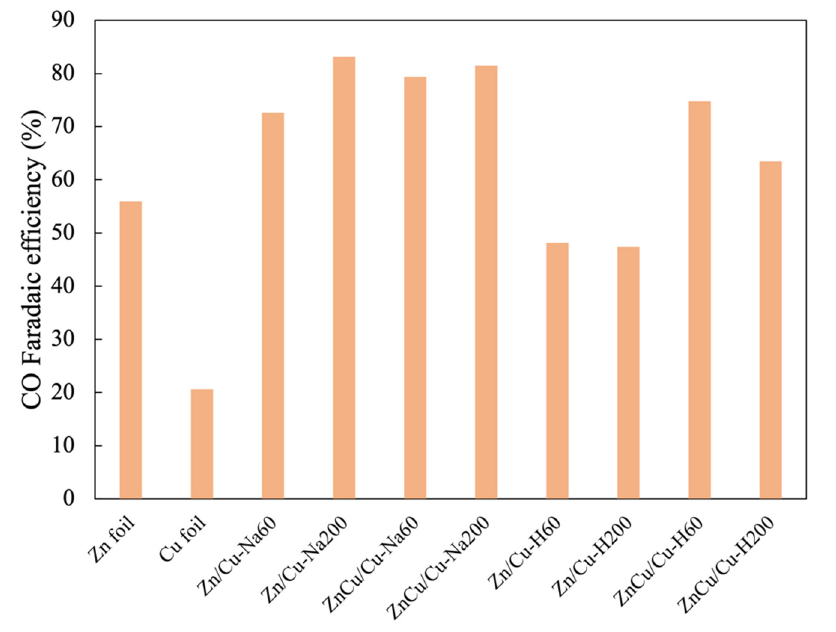
Figure 4. CO Faradaic efficiency measure at − 1.6 V vs. Ag/AgCl.